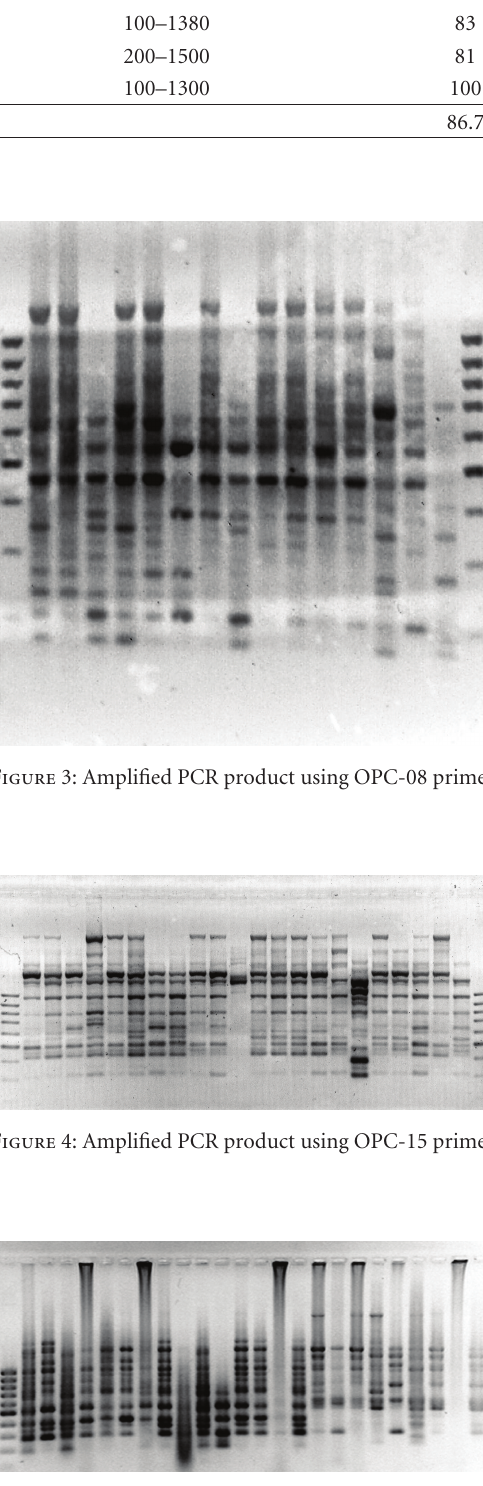
Figure 5: Amplified PCR product using OPC-16